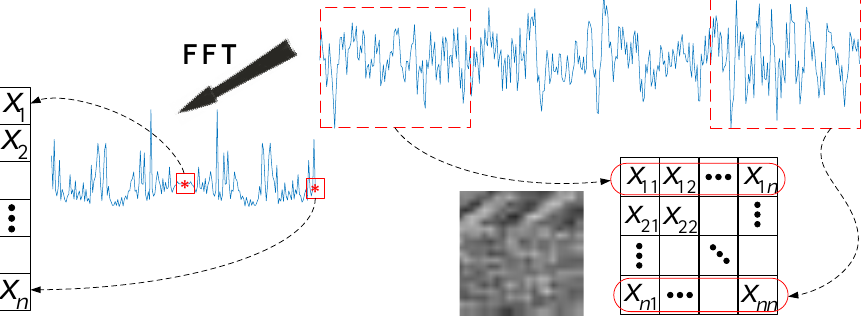
Figure 3. One-dimensional and two-dimensional data transform. The algorithm flow chart of AF-CDN is shown in Figure 4. The main steps of the proposed algorithm are described as Algorithm 1.